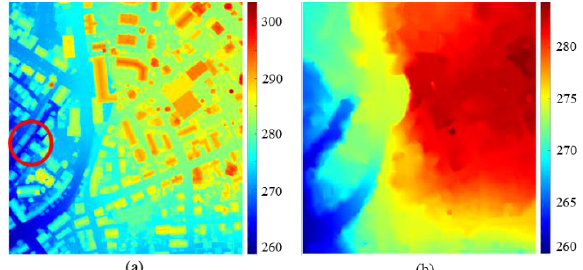
Figure 4. Area1 DSM derived from LiDAR data (a) and the reference DTM (b).